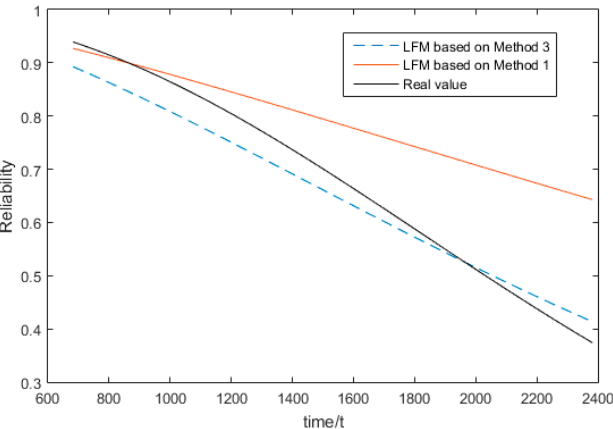
Figure 2. Reliability confidence lower limit comparison.